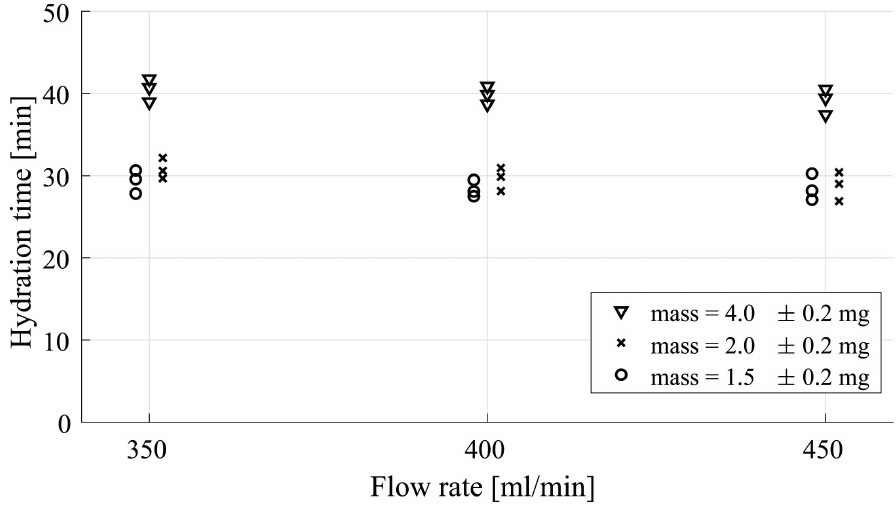
Figure 4. Hydration time for different flow rates and different sample masses. The measurements were executed at a water partial pressure of 12 mbar. The set flow rates were flow rates of 350, 400 or 450 mL/min. Measurements indicated by circles and crosses are shifted slightly horizontally to enhance visibility.